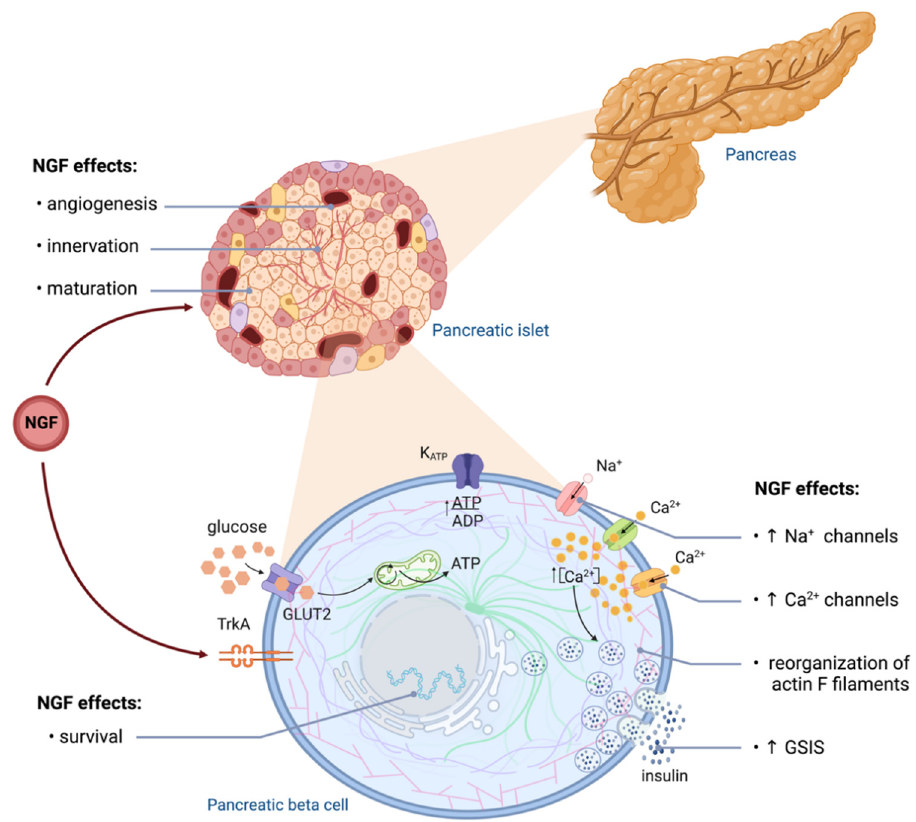
Figure 2. NGF effects on pancreatic beta cells. NGF participates in pancreatic islets’ maturation, favoring innervation and vascularization. In beta cells, NGF favors survival and upregulates key components of the insulin exocytosis process, which increases GSIS. NGF plays an essential role in the functional maturation of pancreatic beta cells from early stages of development. Created with BioRender.com.